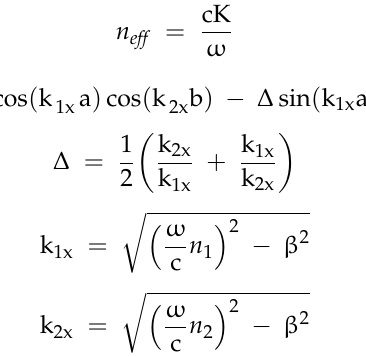
Figure 1. ( a ) Schematic of the conventional directional coupler (DC) and ( b ) the SWG-based wavelength-flattened directional coupler (WFDC) in SOI platform. T is the transmitted power through the input waveguide. X is the evanescently coupled power to the adjacent waveguide. w, h, g and 𝐿 (cid:3030) are the waveguide width, waveguide height, coupling gap and coupling length, respectively. Λ , a and b are the SWG period, silicon width and silicon dioxide width respectively. ɸ 1 , ɸ 2 are the even mode and the odd mode presented in the DC. ɸ 3 is a weakly coupled even mode. ( c ) Dispersion of the fundamental mode in a slab waveguide as shown in the inset. The slab waveguide has 0.4 µm thick Si guiding layer and infinitely thick silicon dioxide cladding. ( d ) Dispersion of the floquet mode in the SWG as shown in the inset. The black glowing line in the insets of ( c , d ) show the E-field of the EM wave as it propagates in the